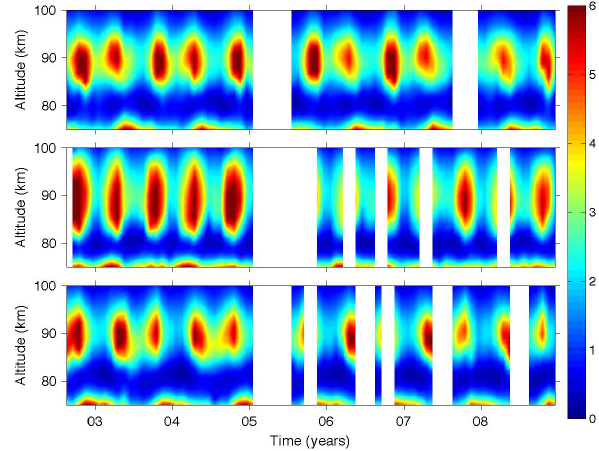
Fig. 4. Monthly ozone number density in the stratosphere in three latitude belts as a function of time and altitude. The density is scaled by 10 12 cm − 3 . The time covered is 1 August 2002–31 December 2008. Latitude belts: 30 ◦ N–50 ◦ N (top), 10 ◦ S–10 ◦ N (middle), 30 ◦ S–50 ◦ S (bottom). White space in the panels means that there are not enough data available.